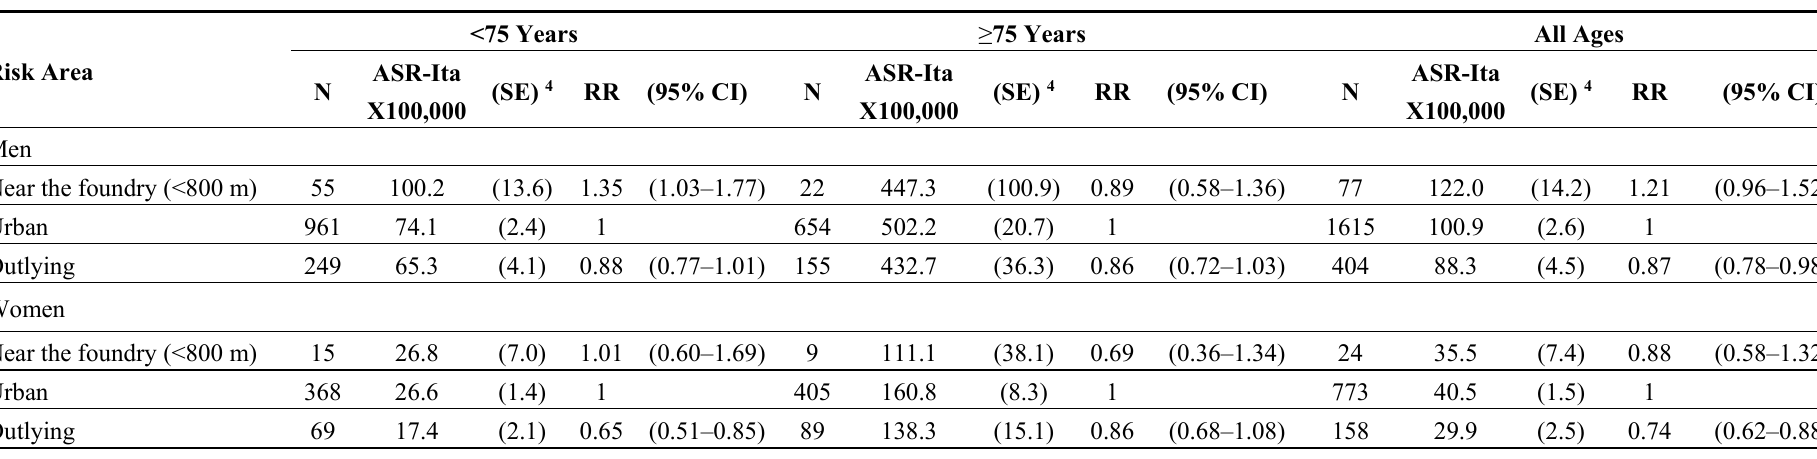
Table 1. Incident cases of lung cancer 1 , age-standardized rates on Italian population (ASR-Ita 2 ) and rate ratios (RR), with corresponding 95% confidence intervals (CI), by sex, and risk area according to age groups during the period 1995–2009 in the municipality of Trieste 3